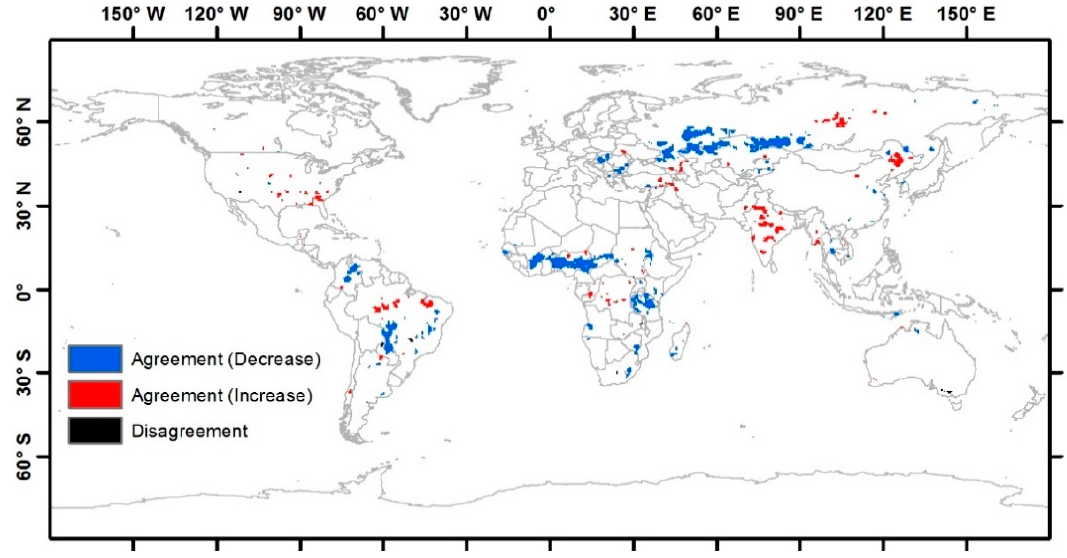
Figure 8. Spatial comparison (Agreement-Disagreement) of significant trends between the common time series (2001–2018) of the burned area datasets.